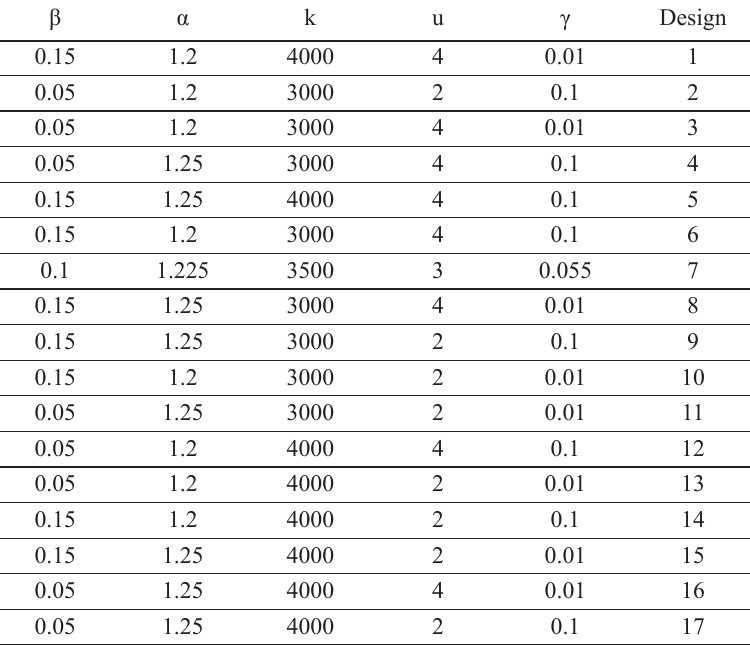
Table 6. Design of